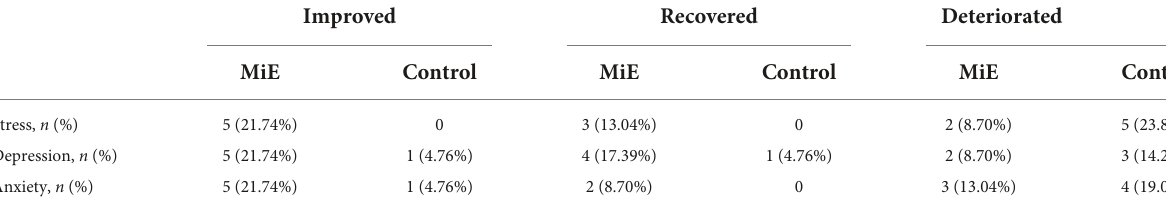
TABLE 4 Percentage of improved, recovered and deteriorated participants according to the Reliable Change Index (RCI).